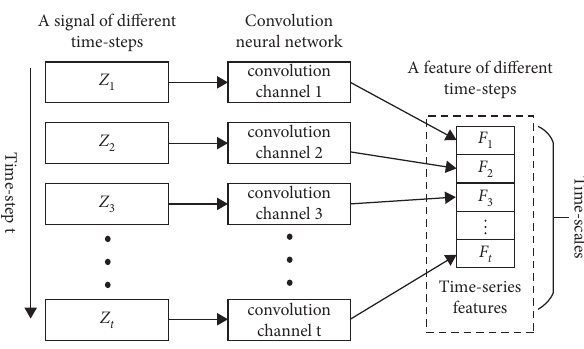
Figure 1: Parallel multichannel convolution building